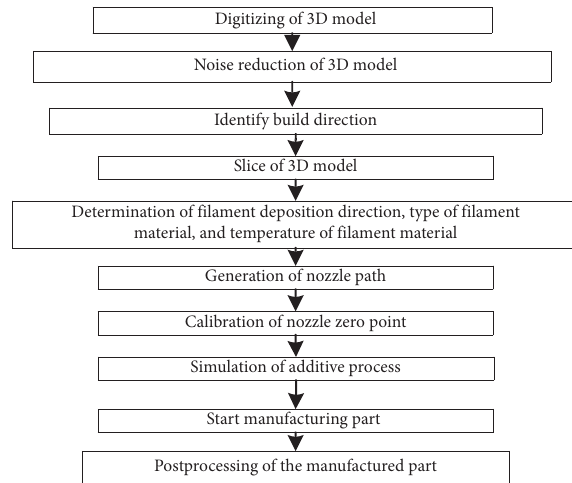
Figure 6: Additive process plan